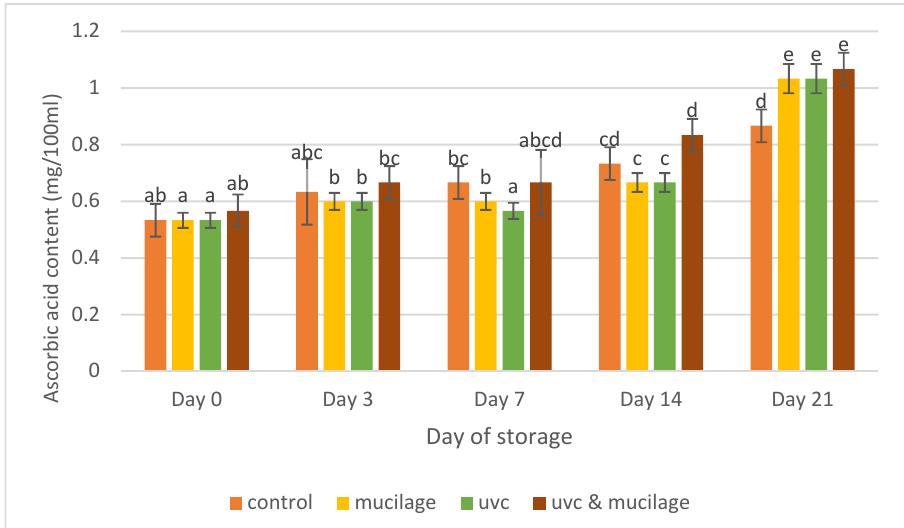
Figure 8. Effect of mucilage coating and UV-C on the ascorbic acid content. Values followed by different letters within the same column are significantly different ( p < 0.05) ( n = 12).